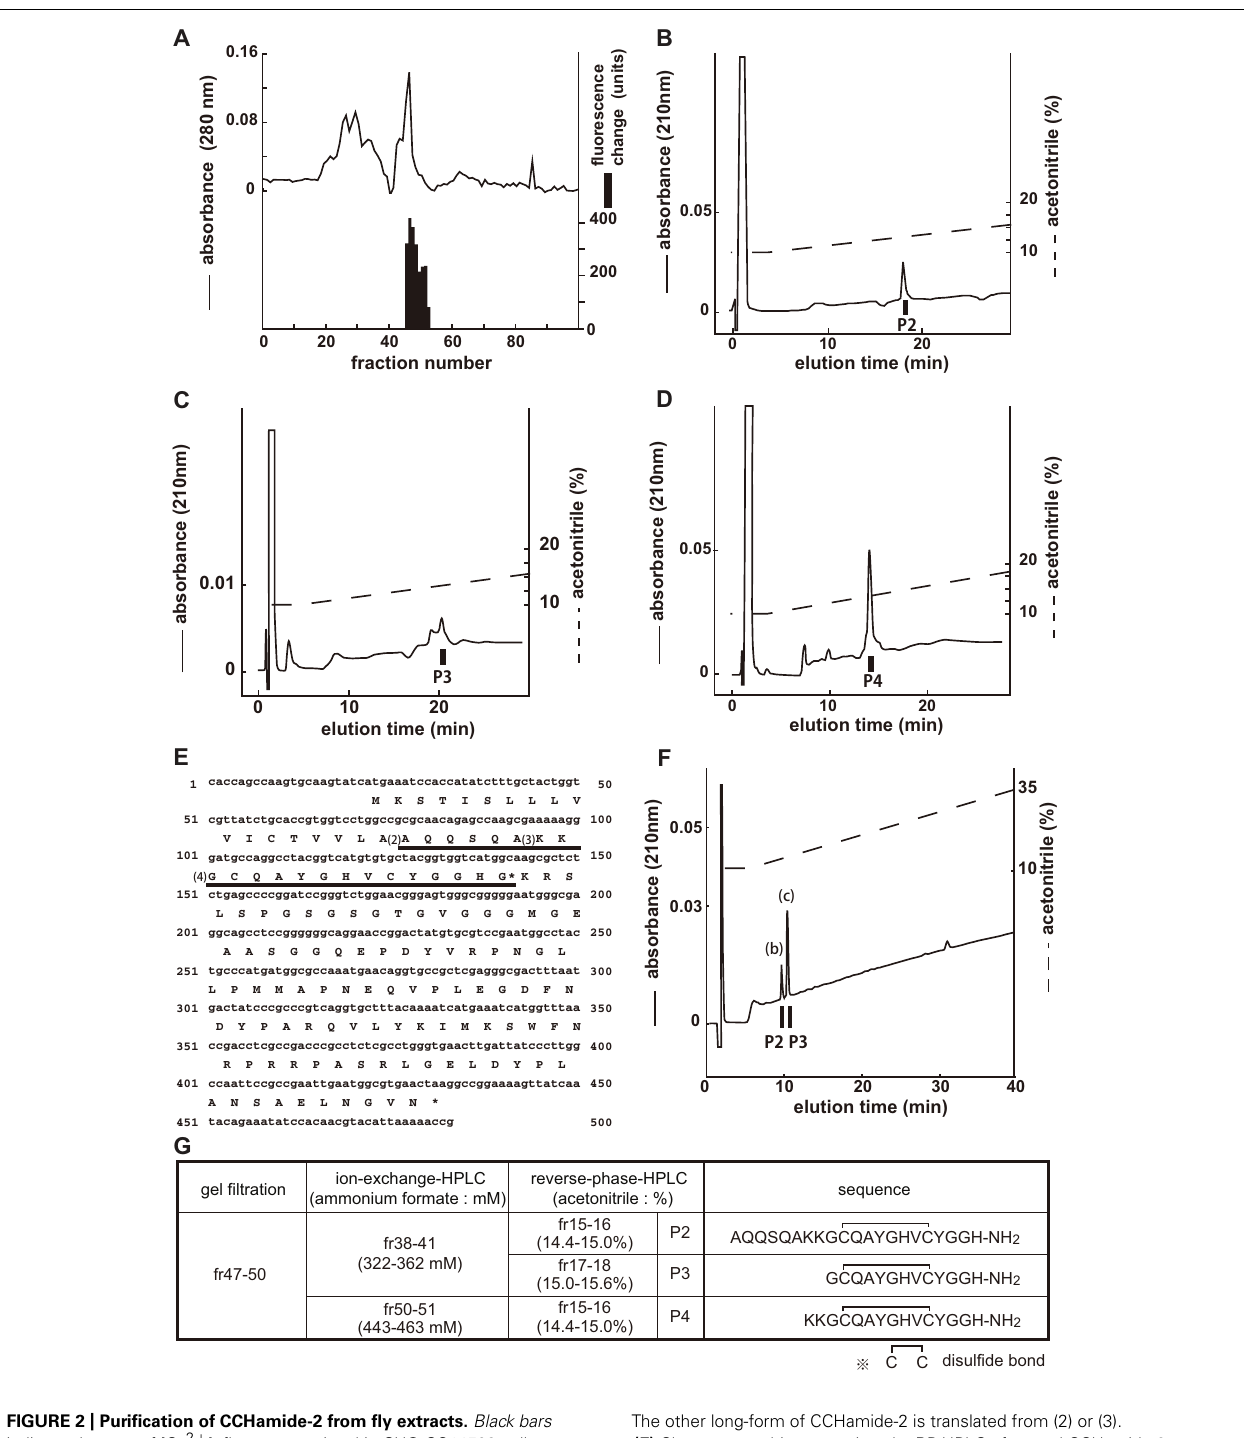
FIGURE 2 | Purification of CCHamide-2 from fly extracts. Black bars indicate changes of [Ca 2 + ] i fluorescent signal in CHO-CG14593 cells. (A) G-50 gel filtration of the SP-III fraction of fly extracts.The active fraction was subjected to one step of CM-ion-exchange HPLC and three steps of RP-HPLC. (B–D) Final purification of the active fraction by RP-HPLC. (E) Nucleotide sequence and deduced amino acid sequence of CCHamide-2 cDNA. CCHamide-2 cDNA encodes a 136-residue peptides. The asterisk indicates a glycine residue that serves as an amide donor for C-terminal amidation.The CCHamide-2 sequence is underlined as (4).